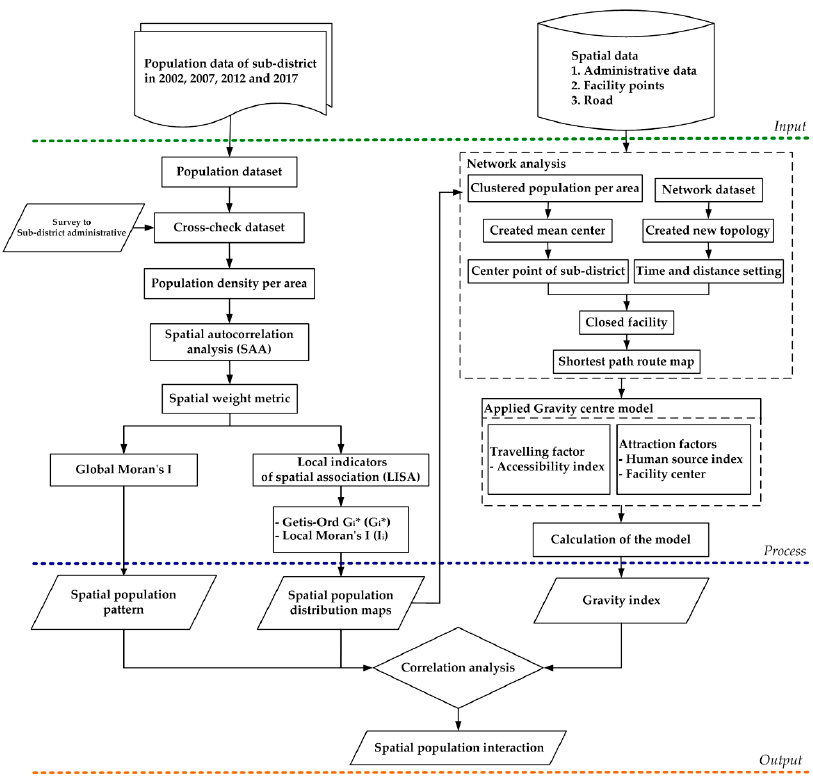
ff ect of population density patterns. ISPRS Int. J. Geo-Inf. 2020 , 9 , x FOR PEER REVIEW